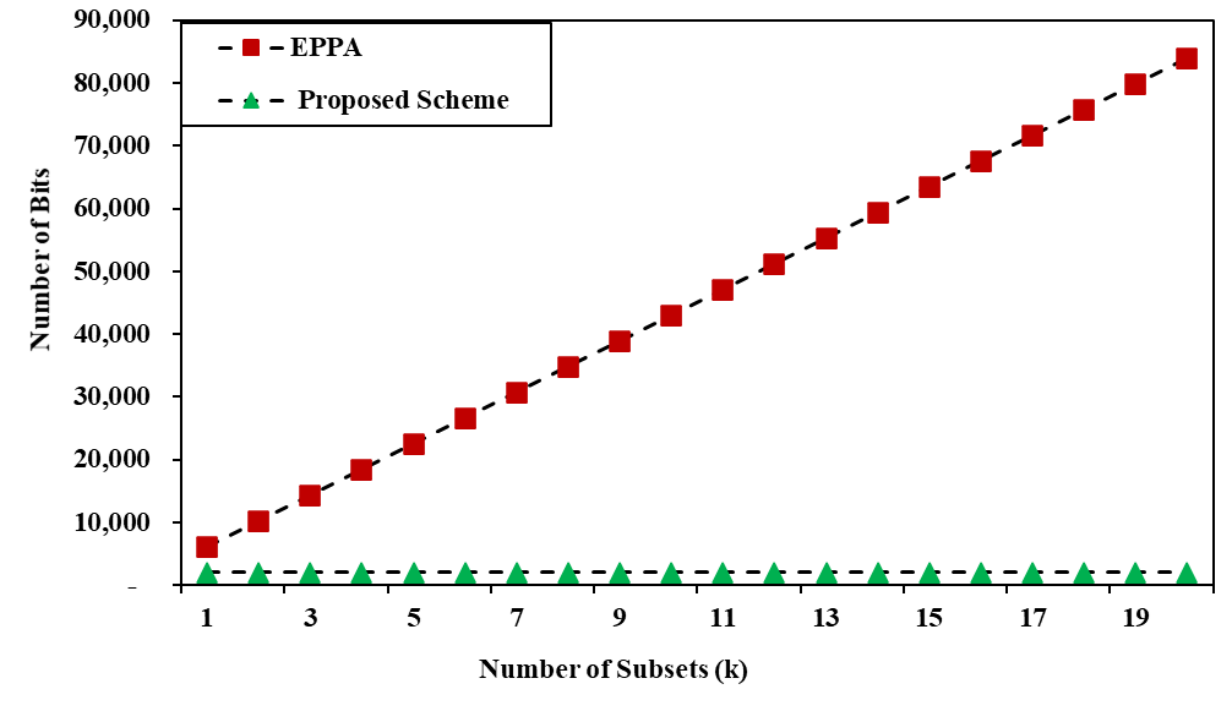
Figure 3. Communication overhead from sink node to smart